Question: Compose a caption that would accompany this figure in a paper.
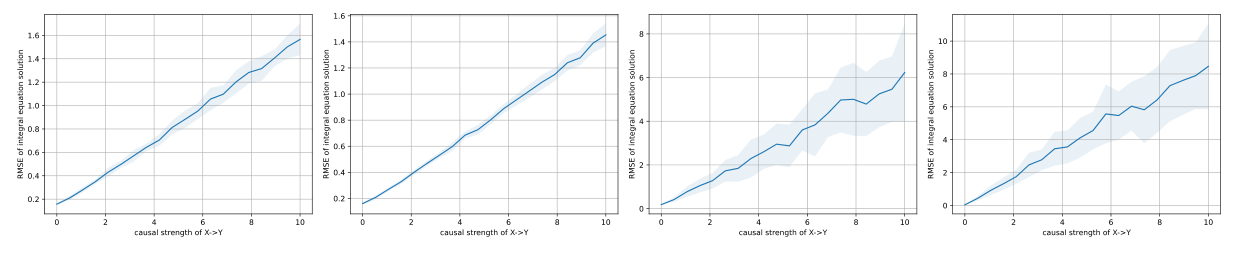
Answer: Insolubility of the integral equation when X ̸⊥⊥Y |U. We consider four examples, namely the linear Gaussian model, the linear nonGaussian model, the nonlinear additive noise model, and the general nonlinear models. For each example, we report the averaged residual of the best fit of the integral equation f(y|x) = R h(y, w)f(w|x)dw wrt to the correlation strength of X and Y . As we can see, when X and Y become strongly correlated (X ̸⊥⊥Y |U), the residual becomes non-zero, indicating the insolubility of the integral equation.